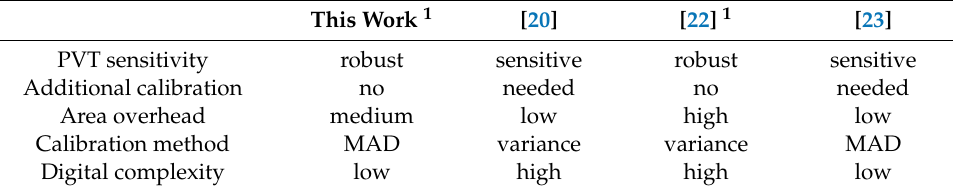
Table 1. Feature comparison.